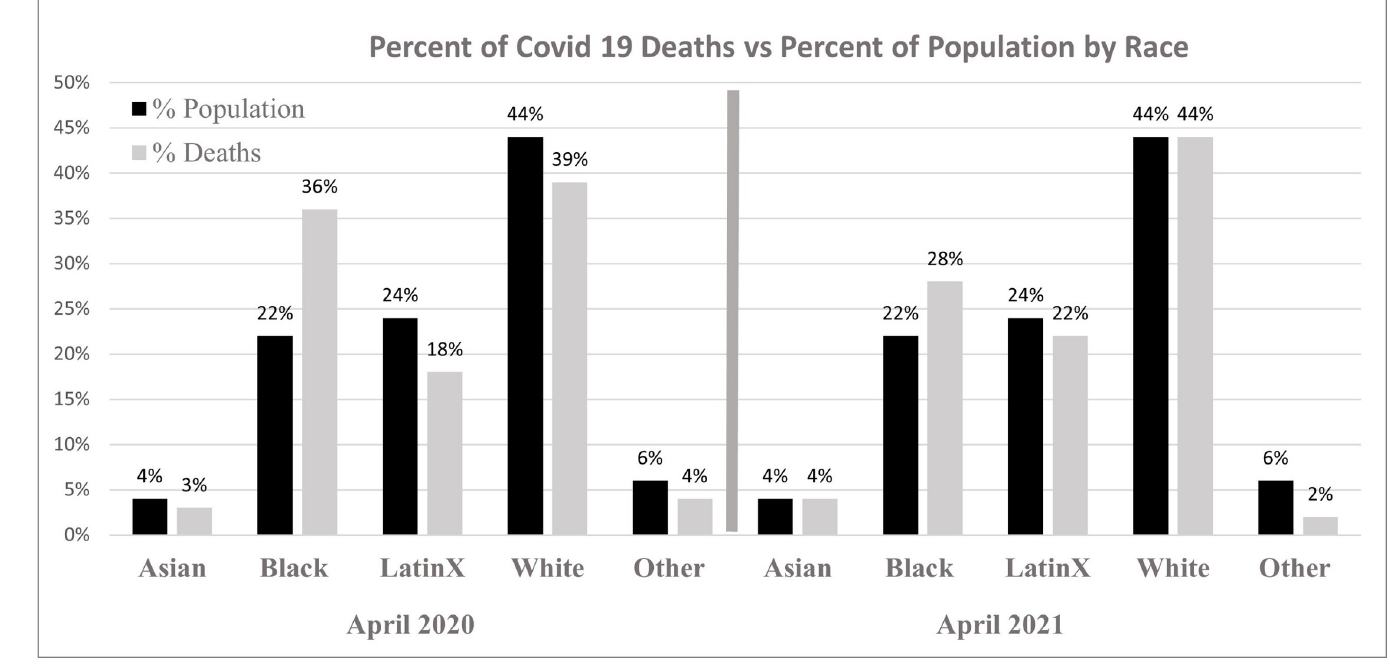
Fig 2. Percent of COVID-19 deaths vs percent of population by